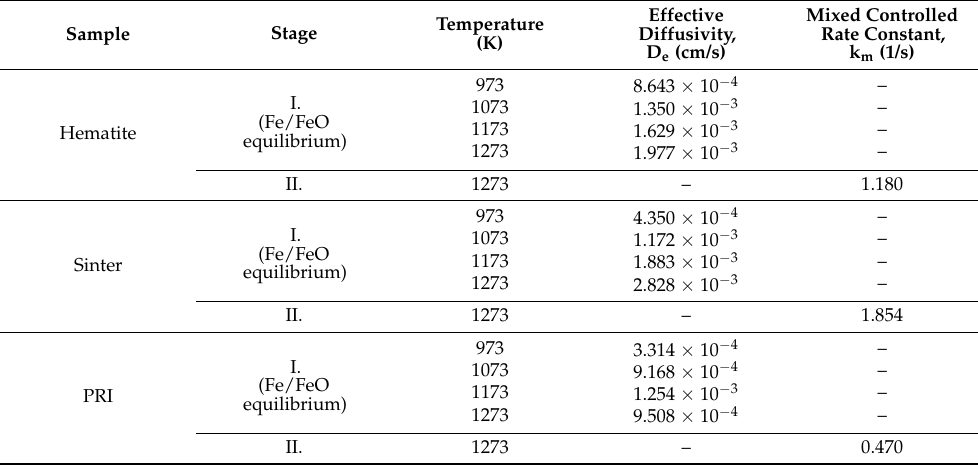
Table 4. Effective diffusivity and mixed controlled rate constants of hematite, sinter, and PRI under experimental conditions in the present